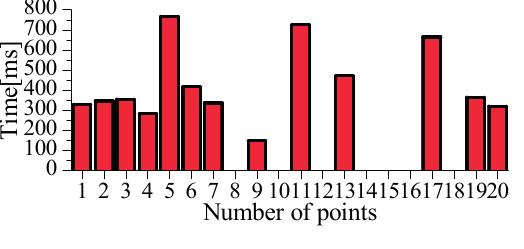
Figure 11. Experimental results of the communication speed